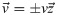
Flip-flop SEMS sequence.In presence of a bidirectionnal flow (v→=±vz→) the second slice of flip will be sensitive to the positive direction inflow (v→=+vz→) while the second slice of flop will be sensitive to outflow (v→=-vz→).